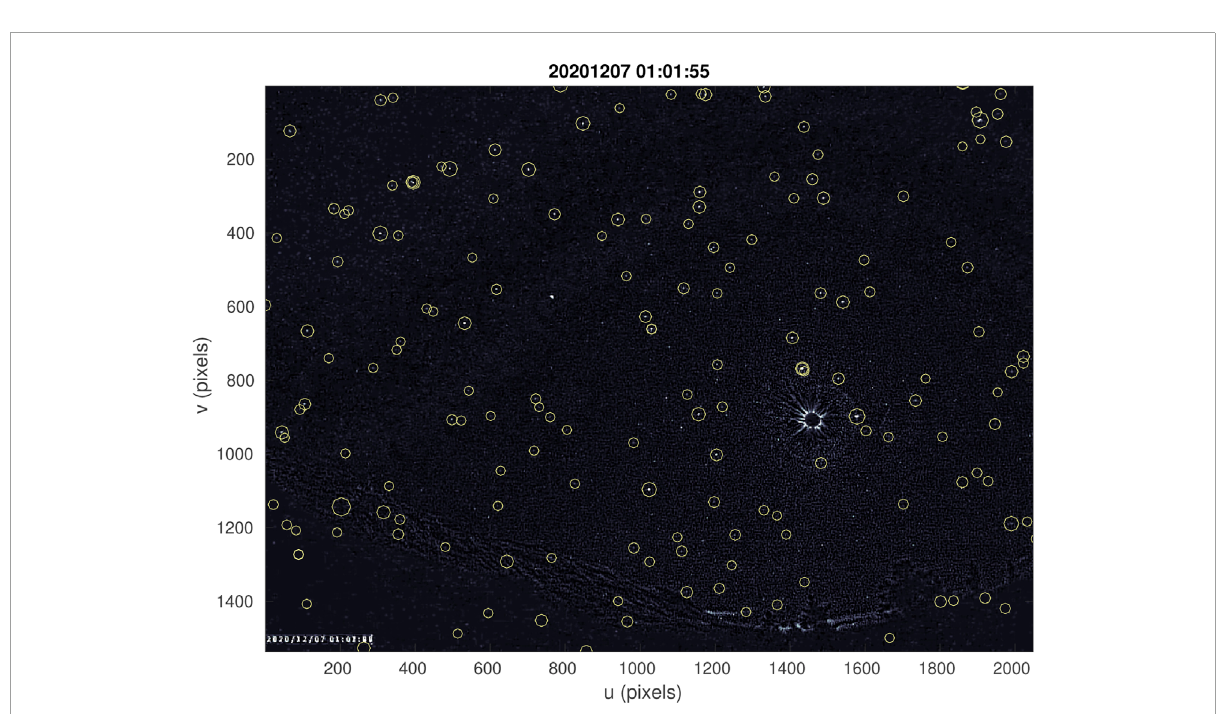
FIGURE 3 An example star calibration image during the first clear night after the fireball (2020-12-07T01:01:55Z).